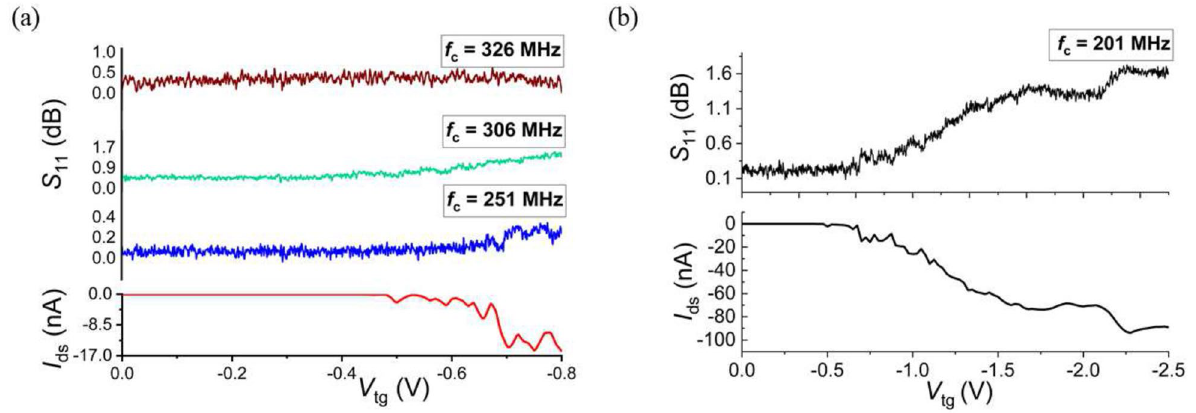
Figure 1. The rf-response at various probing frequencies for device 2. ( a ) Reflectivity response S 11 together with the corresponding DC current as a function of the top gate voltage V tg at 4.2 K. ( b ) Comparison of the rf- and DC responses in the accumulation, depletion and inversion